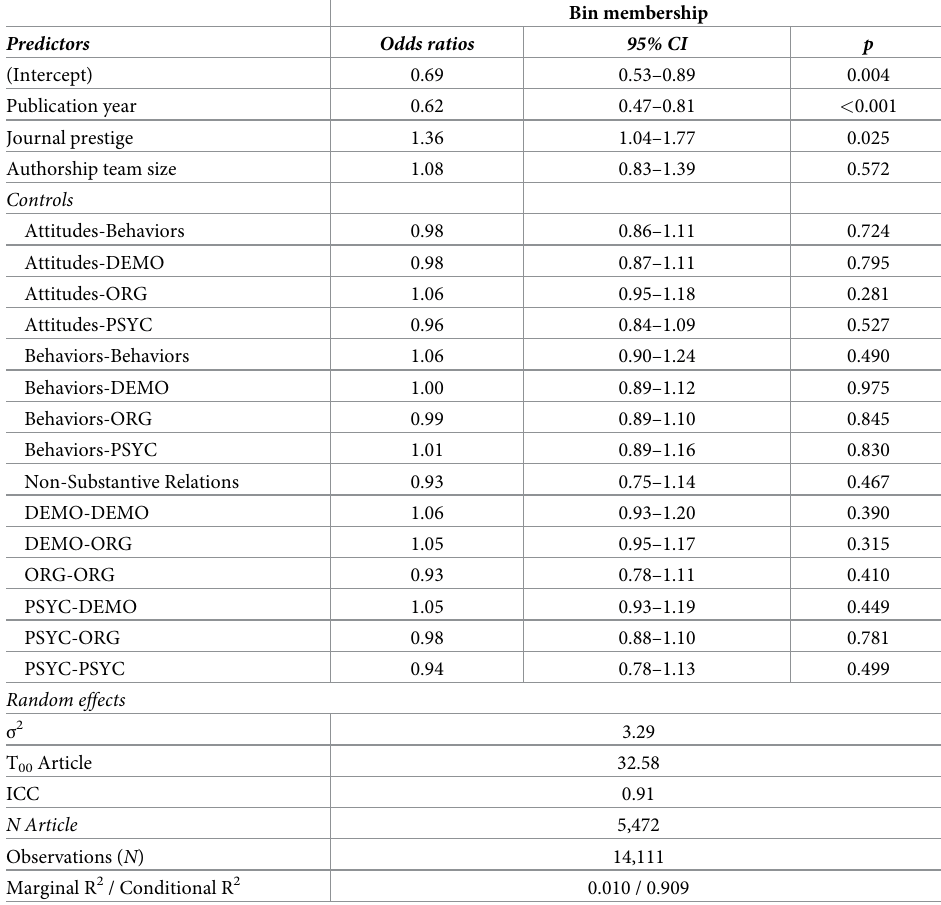
Table 7. Multilevel logit regression results for predictors of bin membership (complete metaBUS